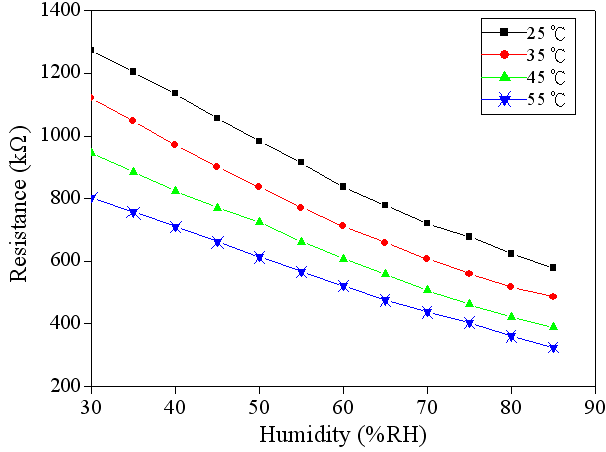
Figure 8. Measured results of the humidity sensor at different temperatures.